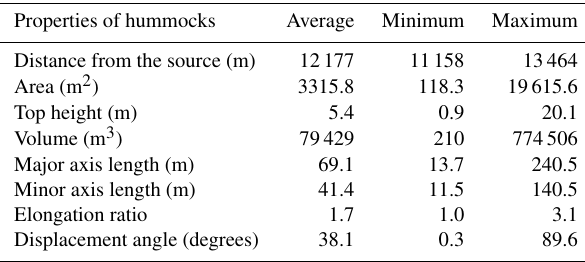
Table 1. Morphological properties of